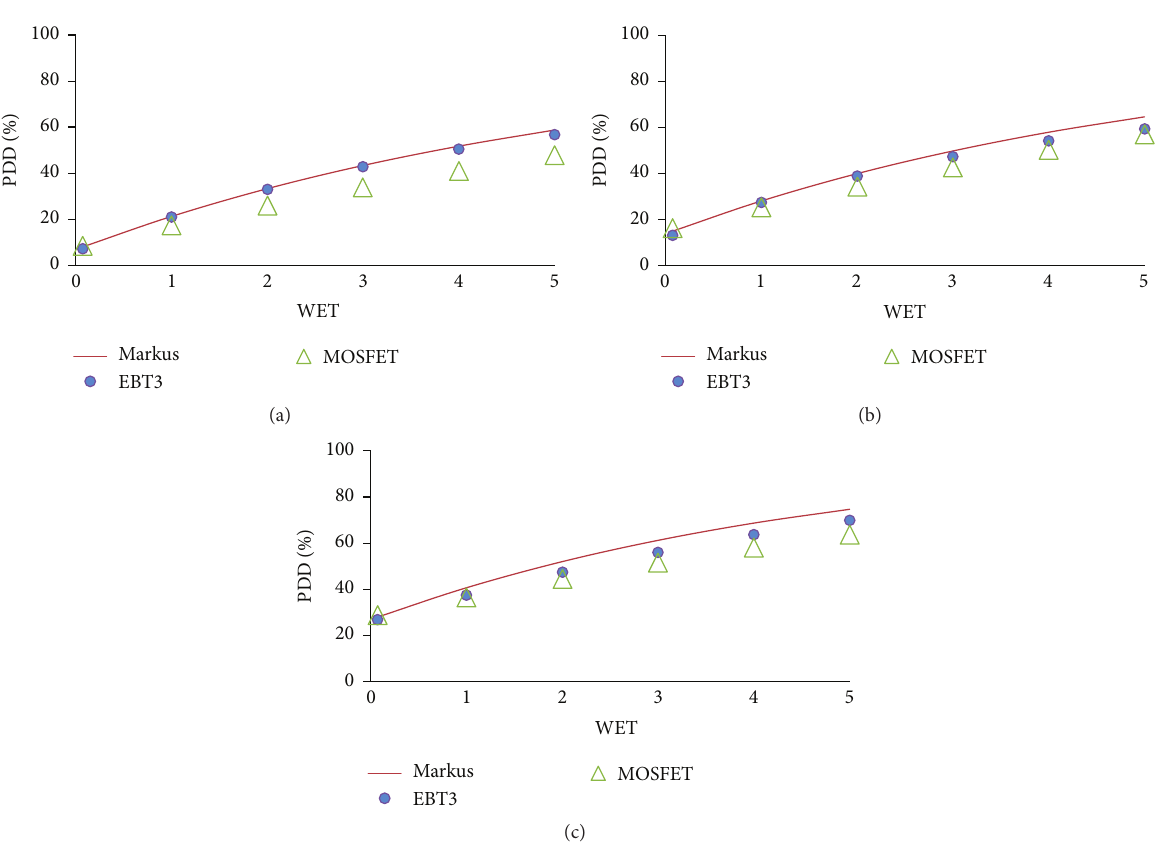
Figure 4: Percentage depth doses (PDDs) for normally incident 15 MV photon beams at open fields with different sizes at 100 cm fixed SSD. The doses at 0, 1, 2, 3, 4, and 5mm effective depths for each dosimeter were calculated by interpolation, and the following field sizes were investigated: 5 × 5 cm 2 (a), 10 × 10cm 2 (b), and 20 × 20 cm 2 (c).